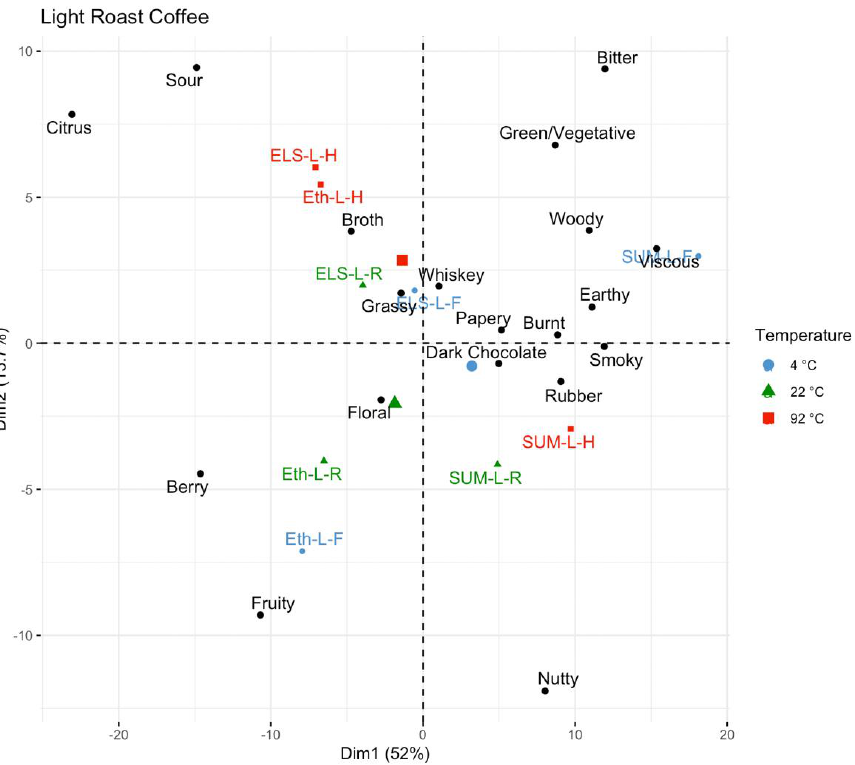
Figure 7. A principal component analysis of the light roast coffees, color-coded by brew tempera-